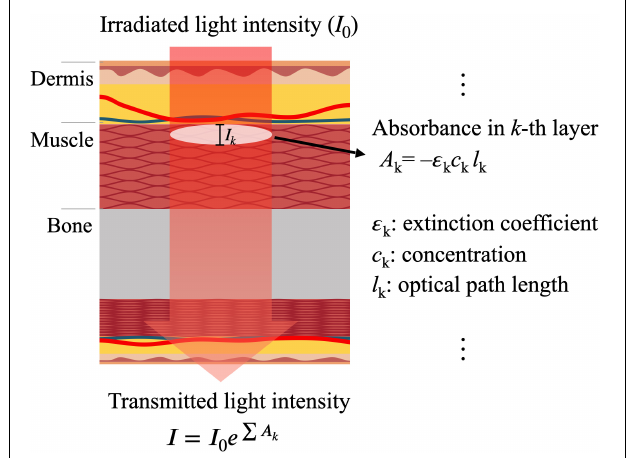
FIGURE 1 | Light intensity change represented with the Beer–Lambert law in photoplethysmogram measurement, where A k , ε k , c k , and l k are the k -th layer absorbance, extinction coefficient, concentration, and optical path length,